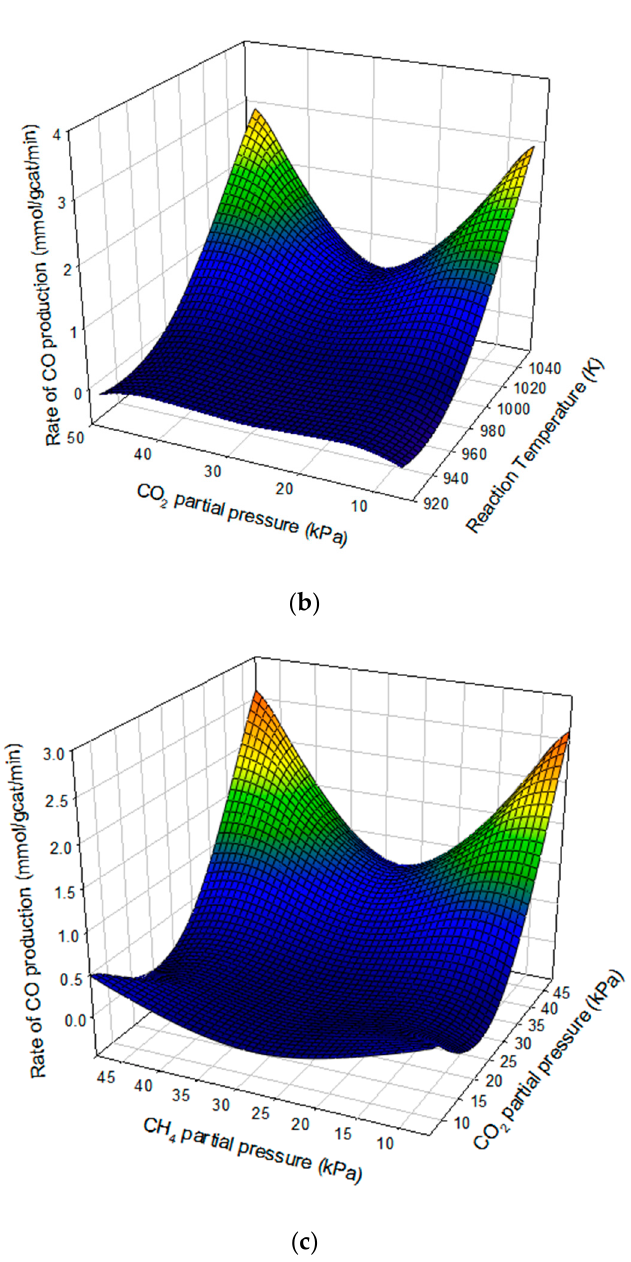
Figure 2. ( a ) Interaction effect of CH 4 partial pressure and reaction partial pressure on the rate of H 2 production; ( b ) Interaction effect of CO 2 partial pressure and reaction temperature on the rate of H 2 production; ( c ) Interaction effect of CH 4 partial pressure and CO 2 partial pressure on the rate of H 2 production.